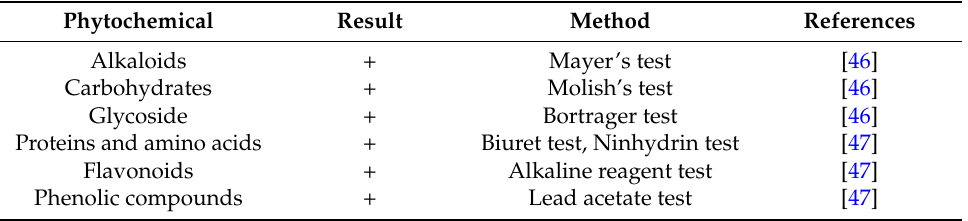
Table 2. Phytochemical analysis of Quercus incana.